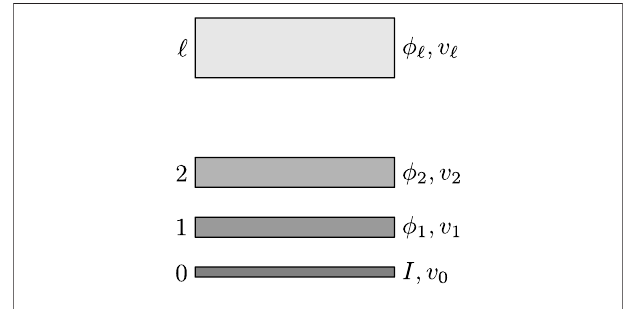
FIGURE 6 | Different visual features along with the corresponding velocity fi